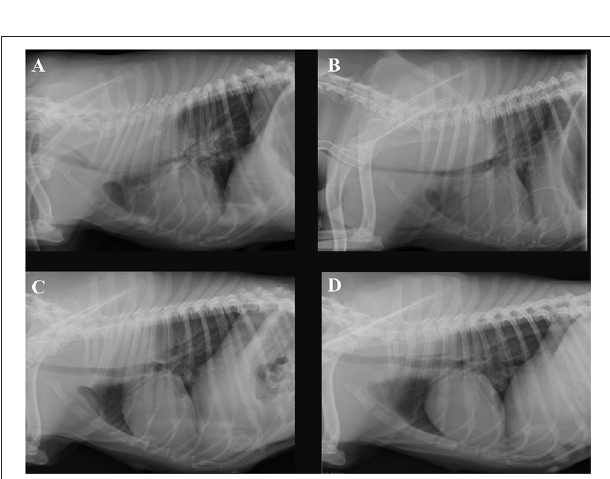
FIGURE 1 | Bedside ultrasound of the thorax. Left paracostal view of a 4-year old female Boxer with mediastinal hematoma. Located dorsally to the heart, a hyperechoic well-demarcated intrathoracic structure is pictured.